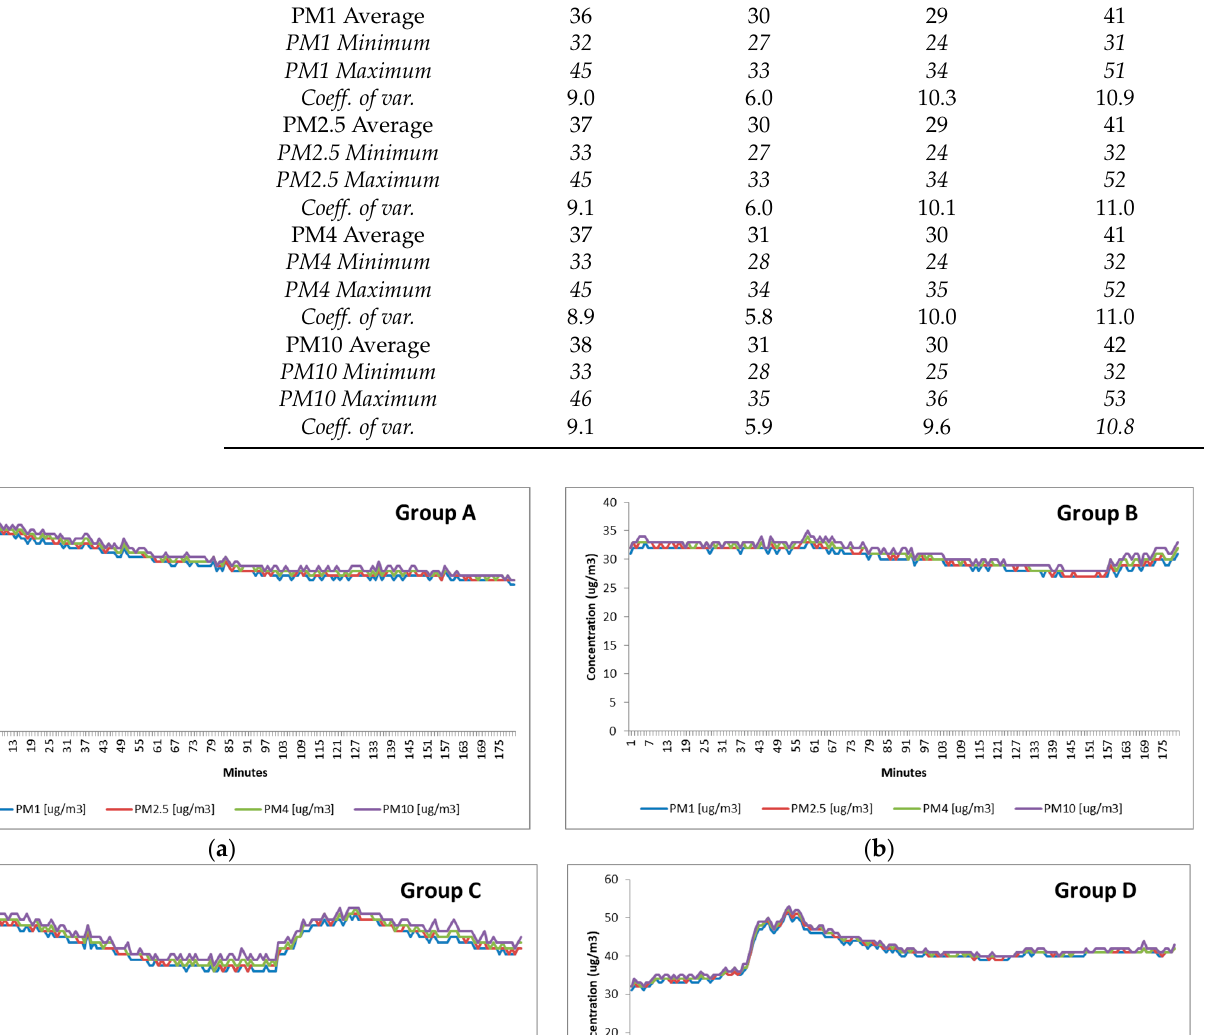
Table 3. Particle counts and indoor microclimate recorded using the Lighthouse HH 3016 IAQ.